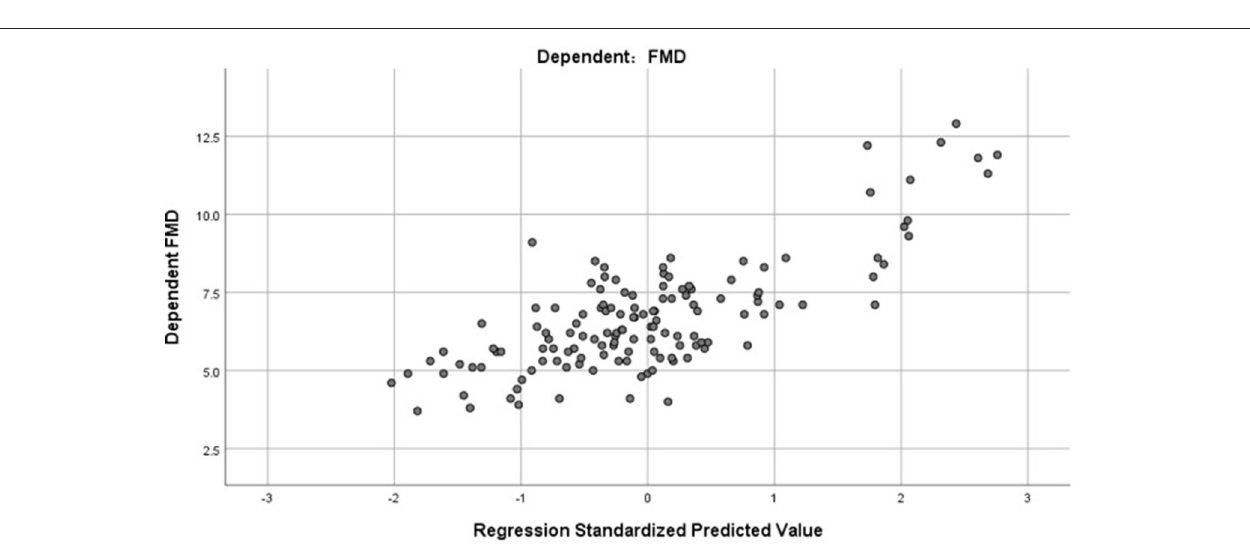
FIGURE 4 | The scatter plot of standardized predicted value and dependent